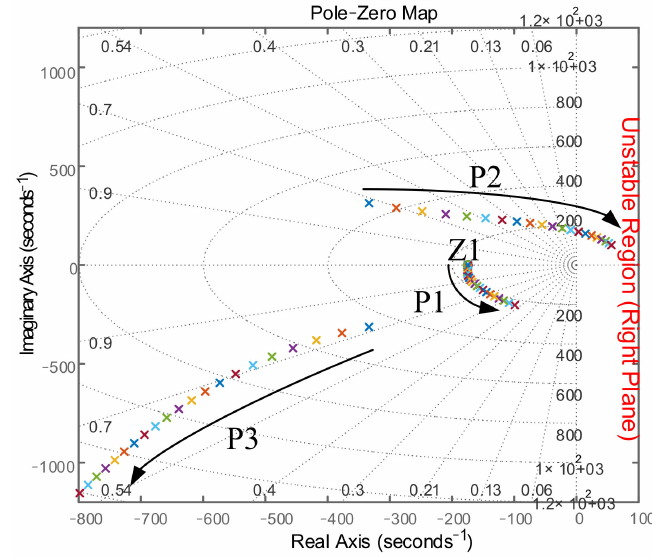
Figure 10. Closed-loop pole-zero map of feed-back decoupling